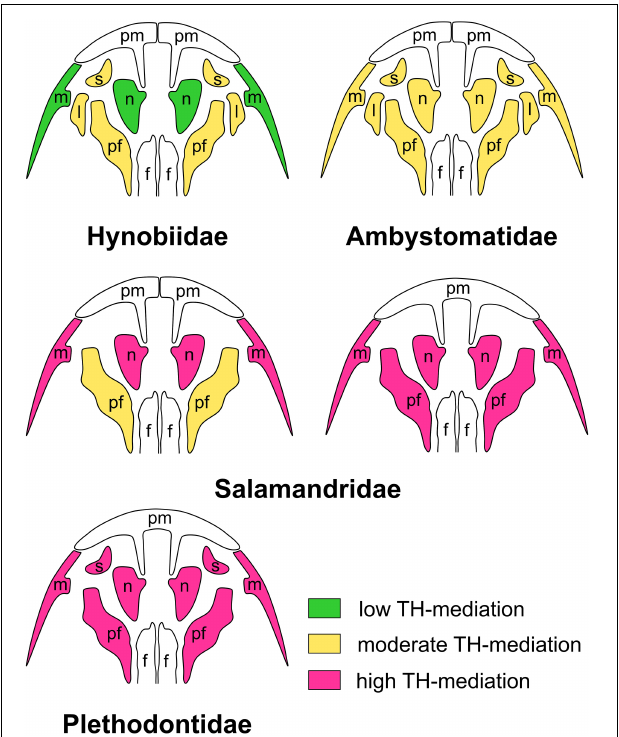
FIGURE 7 | Levels of TH-mediation of the development of late-larval cranial bones in experimentally studied urodelan amphibians treated with exogenous triiodothyronine, T 3 , and thiourea, TU: hynobiid Salamandrella keyserlingii (after Smirnov et al., 2011); ambystomatid Ambystoma mexicanum (after Smirnov and Vassilieva, 2005); salamandrids Pleurodeles waltl (after Smirnov et al., 2020) and Lissotriton vulgaris (after Smirnov and Vassilieva, 2003); and perennibranchiate plethodontids treated with thyroxine, T 4 (after Rose, 1995a,b, 1996, 2003). “Low TH-mediation” implies that the bone forms normally in all specimens under TH-deficiency and is only slightly accelerated and delayed under T 3 - and TU-treatment, respectively; “moderate TH-mediation” implies that the bone appears in all specimens under TH-deficiency but is markedly accelerated under T 3 -treatment and delayed (and possibly deviant) under TU-treatment; “high TH-mediation” implies that the bone is markedly accelerated under T 3 -treatment and does not form (or is rudimentary) in all specimens under TU-treatment. Abbreviations: l, lacrimal; m, maxilla; n, nasal; pf, prefrontal; pm, premaxilla; s,